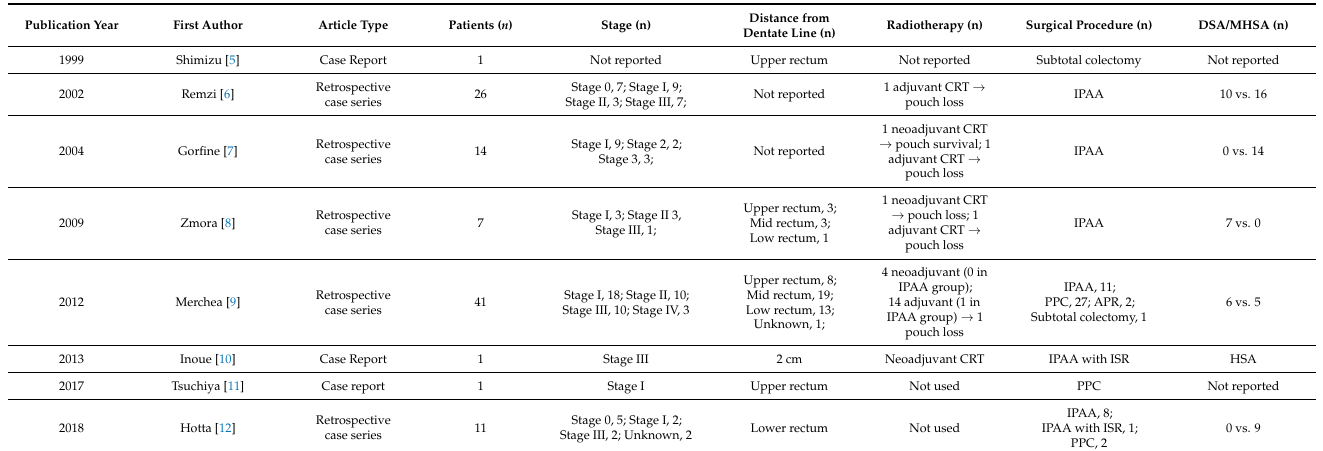
Table 1. Rectal cancer in ulcerative colitis